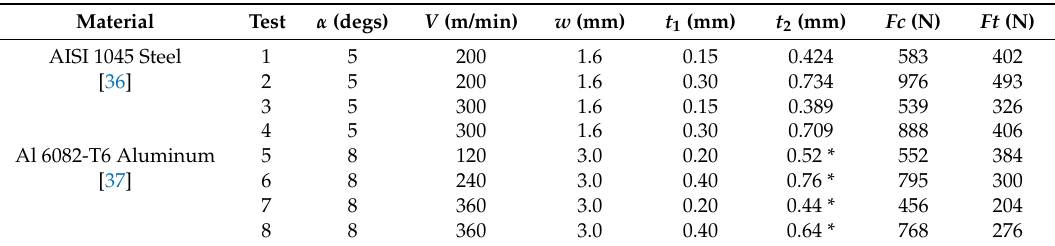
Table 2. Cutting conditions and experimental measurements for machining AISI 1045 steel and Al 6082-T6 aluminum.